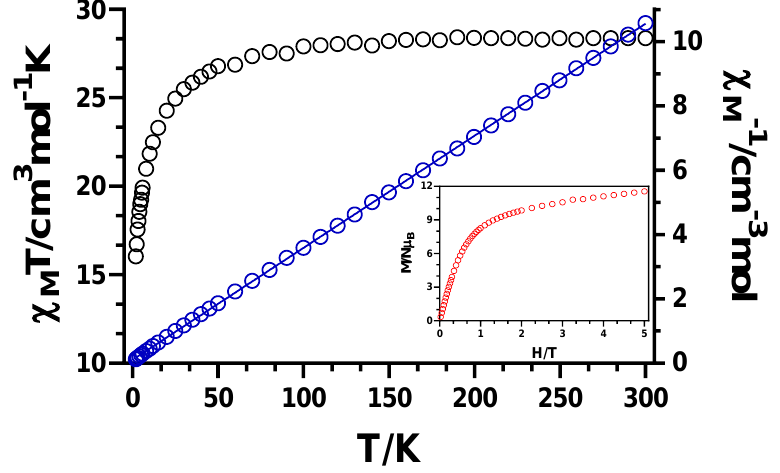
Figure 4. Temperature dependence of the χ M T product (colour black) and 1 / χ M (colour blue) versus T for 1 in the 2–300 K range. The solid line represents the best fitting with the Curie–Weiss law. Inset: Magnetization vs. H plot recorded at 2.0 K.